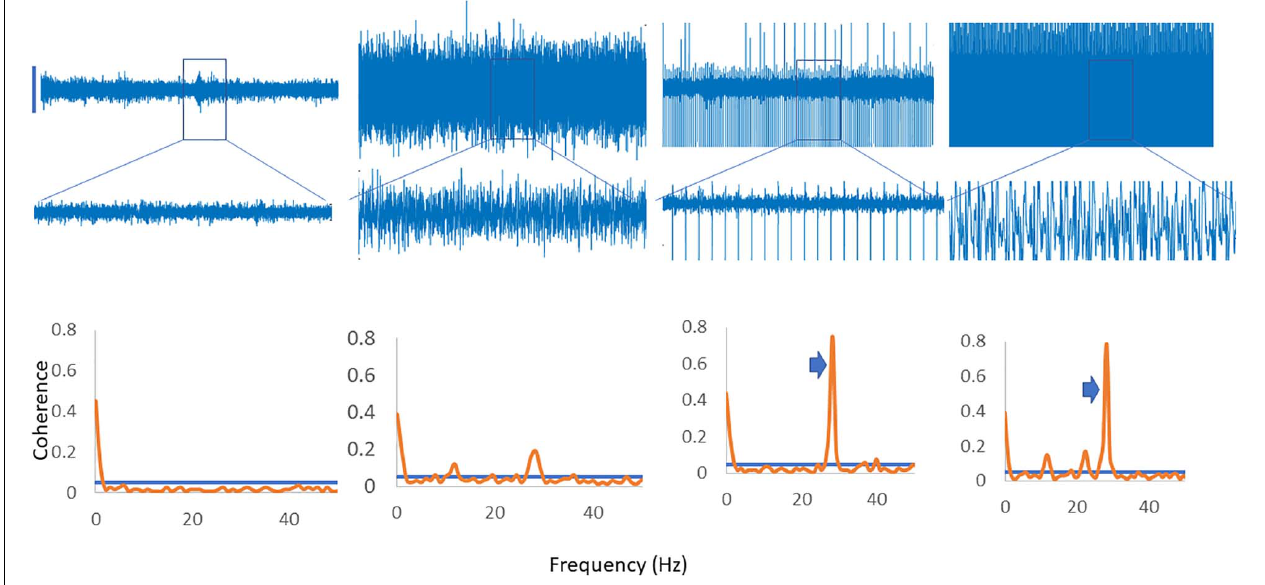
FIGURE 3 | Four columns of data from the leg are shown in this figure. Row 1 has raw EMG from the stimulated muscle, while row 2 highlights an expanded portion of that EMG, and row 3 shows coherence between the stimulated and the unstimulated, synergistic muscle. In the first column there is no activity, and hence no coherence. The second column has a background contraction, but no stimulation while the third column has stimulation but no contraction. The fourth column shows both stimulation and contraction simultaneously. In the coherence plots the arrows indicate the peak in the coherence as a result of the stimulation.